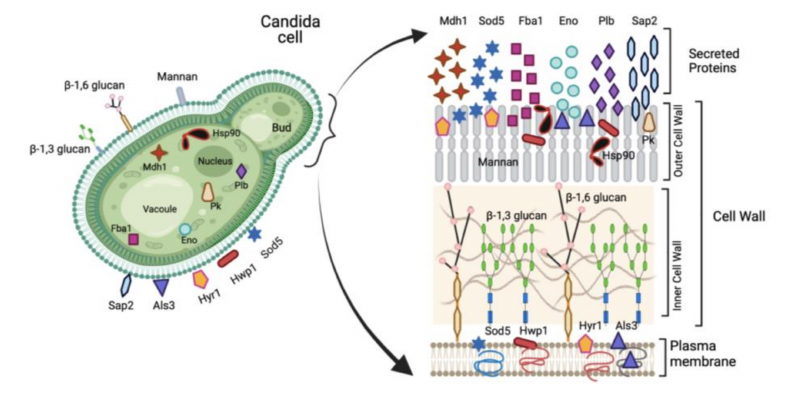
Figure 2. Schematic representation of Candida vaccine antigens. Yeast form of Candida depicted on left indicating major virulence antigens explored as vaccine candidates. Cytoplasmic location of Hsp90, Pk, Eno, Plb, Fba1 and Mdh1 is indicated along with various cell surface antigens (Sap2, Als3, Hyr1, Hwp1, Sod5, glucan and mannan). Cell surface is expanded on right to indicate secreted (Mdh1, Sod5, Fba1, Eno, Plb and Sap2), and cell wall associated antigens (Hyr1, Hwp1, Sap2, Als3, Eno, Hsp90, Pk, Plb, Sod5, Fba1, glucan and mannan). (Created with